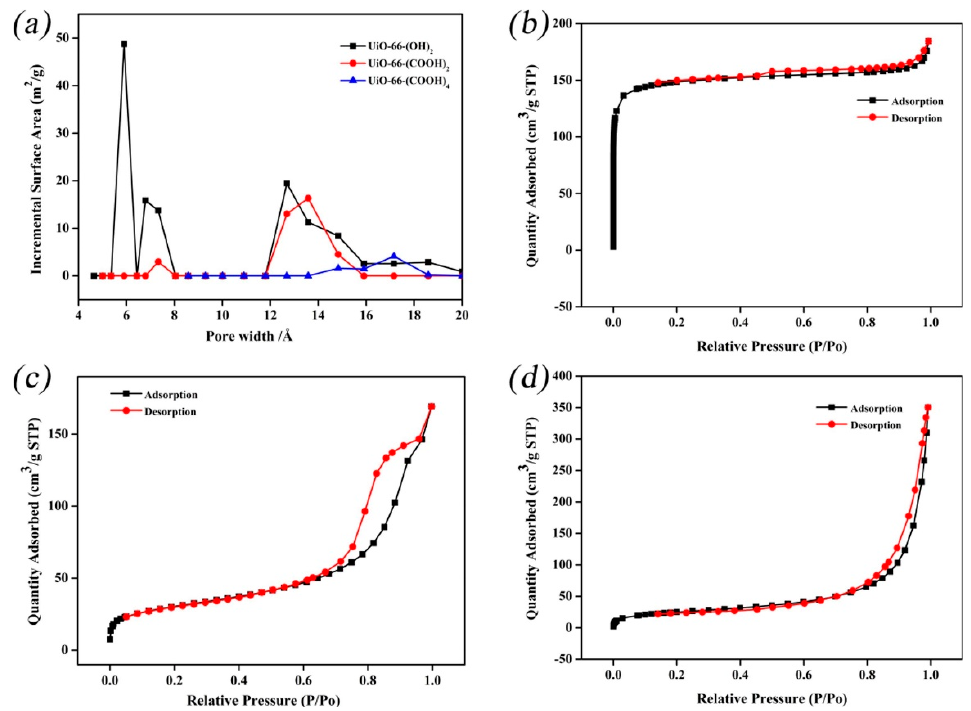
Figure 28. ( a ) Pore size distribution of UiO_66_X nanoparticles; N 2 adsorption-desorption isotherms: ( b ) UiO_66_(OH) 2 ; ( c ) UiO_66_(COOH) 2 ; ( d ) UiO_66_(COOH) 4 .